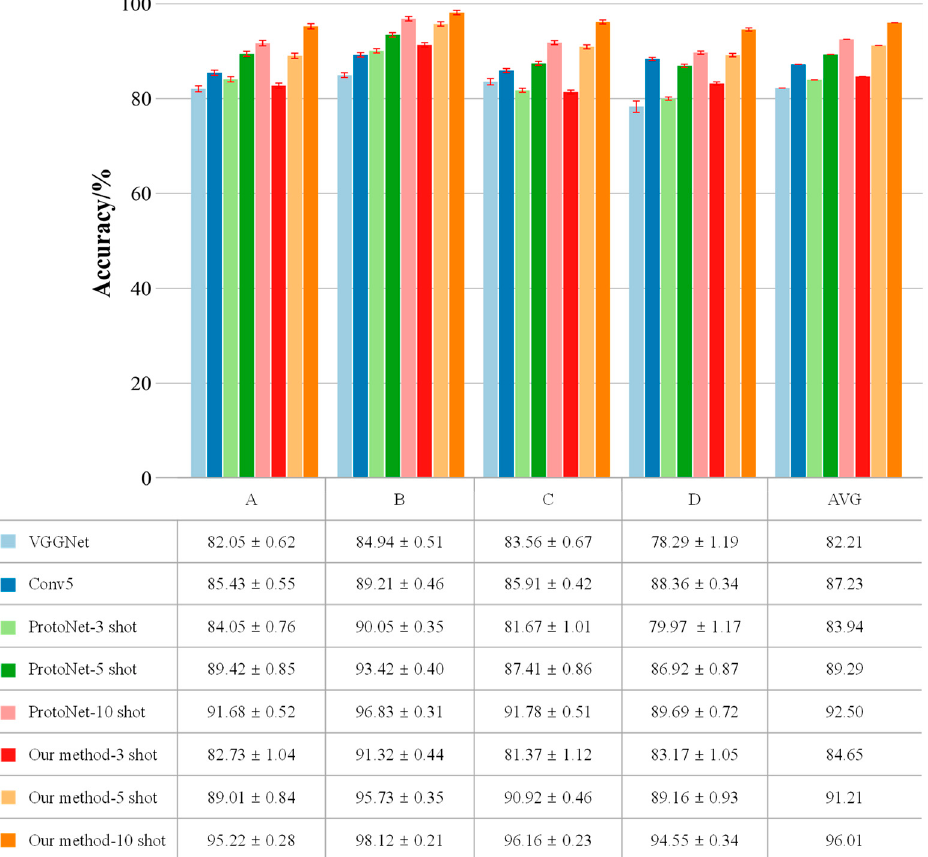
Figure 8. Identification accuracy (%) of recognition under different methods.